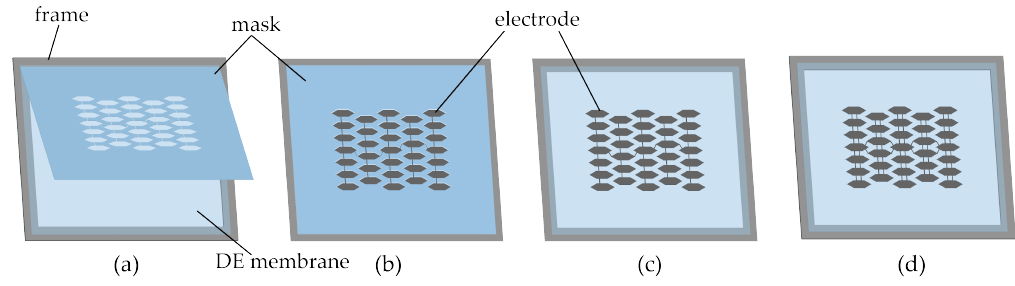
Figure 2. Fabrication process of patterning curable electrodes on a DE membrane.